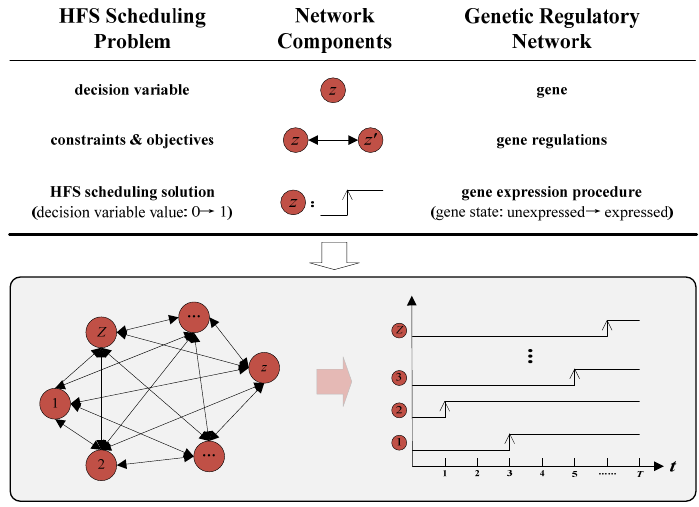
Figure 2. Mapping between the HFS (Hybrid Flow Shop) scheduling problem and a GRN.